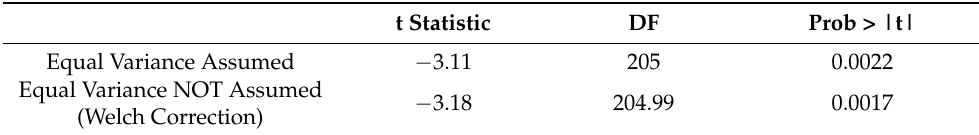
Table 3. The paired-sample t -test of the dislocation loop size distribution in both